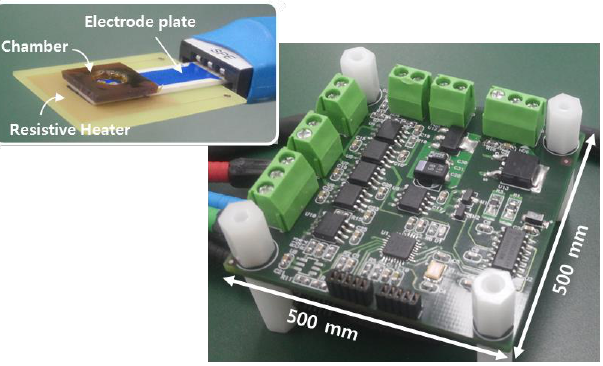
Figure 3. Picture of a prototype circuit platform with functionalized electrodes. The inset shows the photograph of electrochemical sensors on a resistive heater.